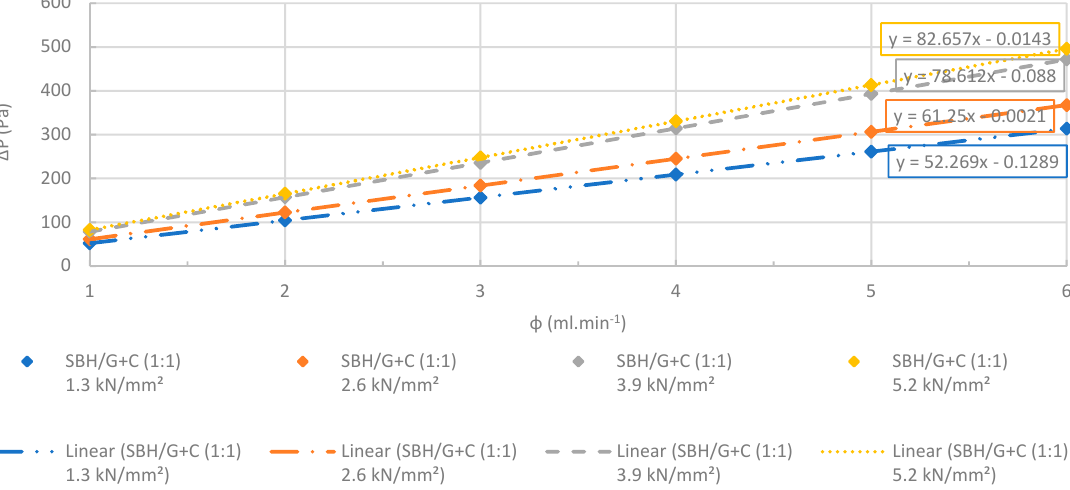
Figure 23. Changes at differential pressures of the SBH pellets with increasing flow rates. R 2 > 0.99. The accuracy of the pressure measurements was less than 0.1%.